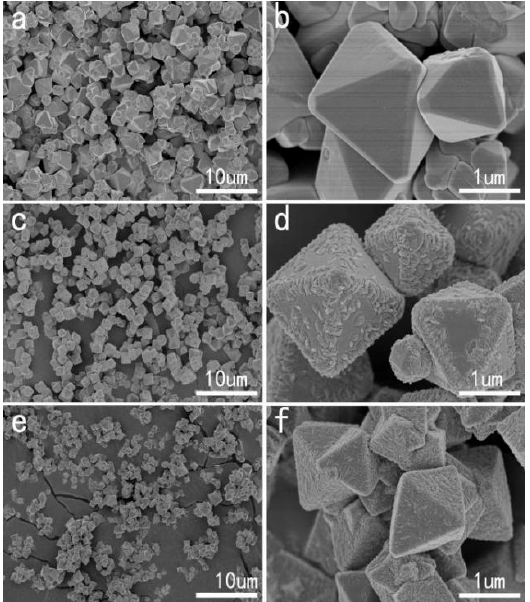
Figure 4. Scanning electron microscopy (SEM) images of ( a , b ) Cu 2 O ‐ NO 3 , ( c , d ) Cu 2 O ‐ Cl(1), and ( e , f ) Cu 2 O ‐ Cl (2).